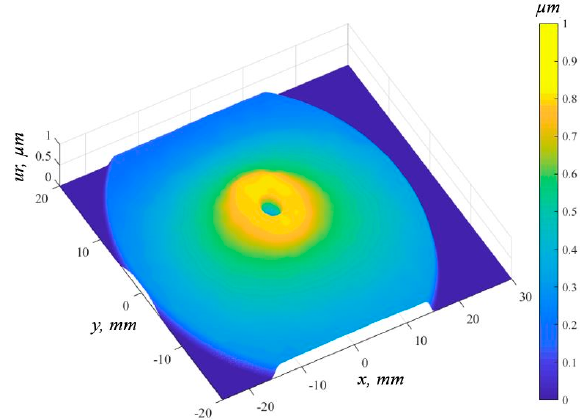
Figure 7. Measurement of the deformation ur of the surface.